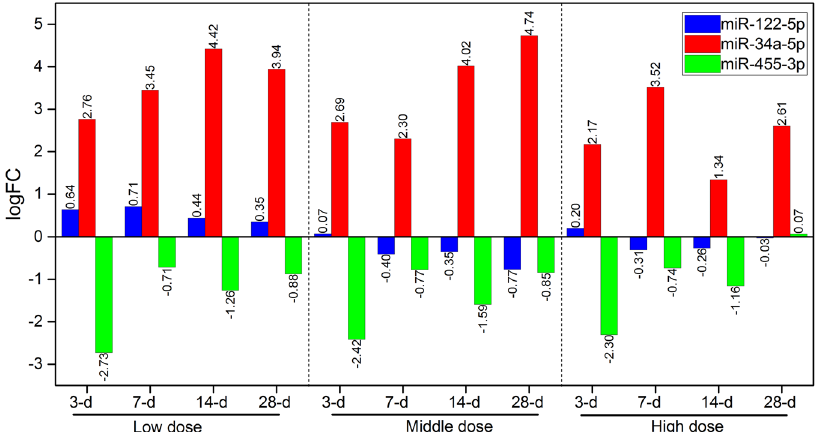
Figure 6. Overview of expression patterns of 2 early and sensitive miRNAs. From the top, the logFC expression of rno-miR-122-5p is not significantly differentially expressed when compared with control animals. Rno-miR- 34a-5p is highly significantly and consistently overexpressed among different doses and time points, suggesting the potential of this miRNA to be considered as an early and sensitive biomarker for monitoring TAA-induced hepatocarcinogenesis during low to high exposures. At the bottom of this figure, the higher expression values of rno-miR-455-3p in the control compared to treated samples, as a result, this miRNA is identified as significantly downregulated with all three doses and all four time points. The highest down-regulation of this miRNA is observed at 3-d with all three doses. The absolute fold change values are used to plot this